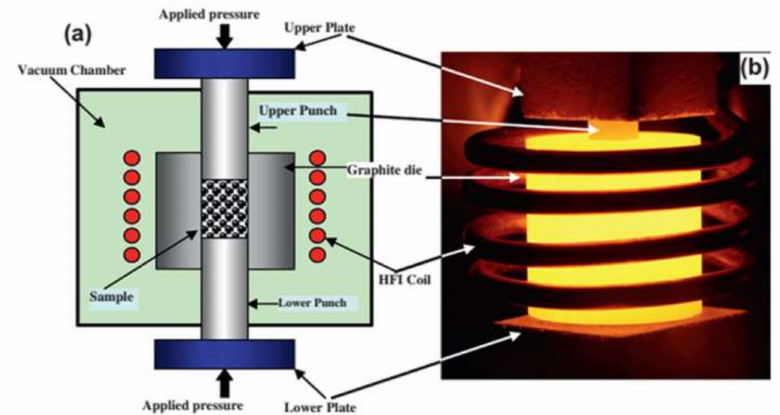
Figure 1. ( a ) High-frequency induction heated sintering apparatus and ( b ) heated die [22]. (© 2012, Elsevier. Used with permission).